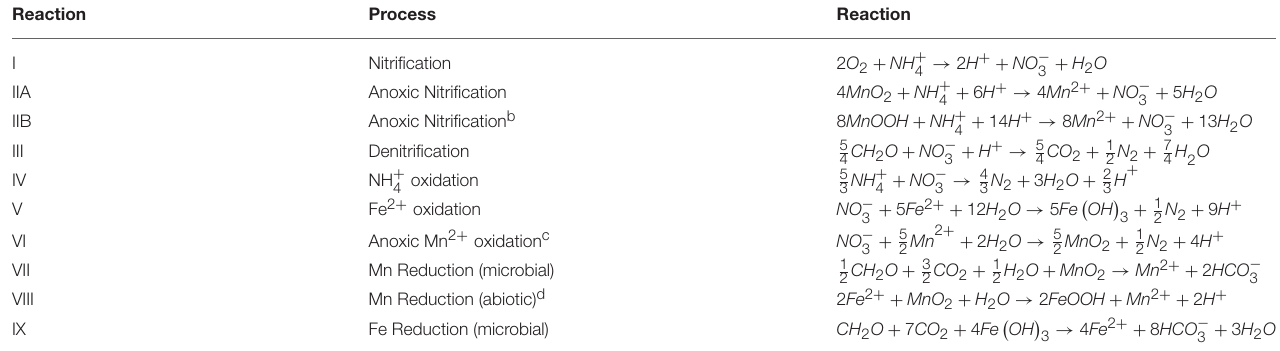
TABLE 4 | Stoichiometries of known and hypothetical pathways of sedimentary redox processes. Reaction